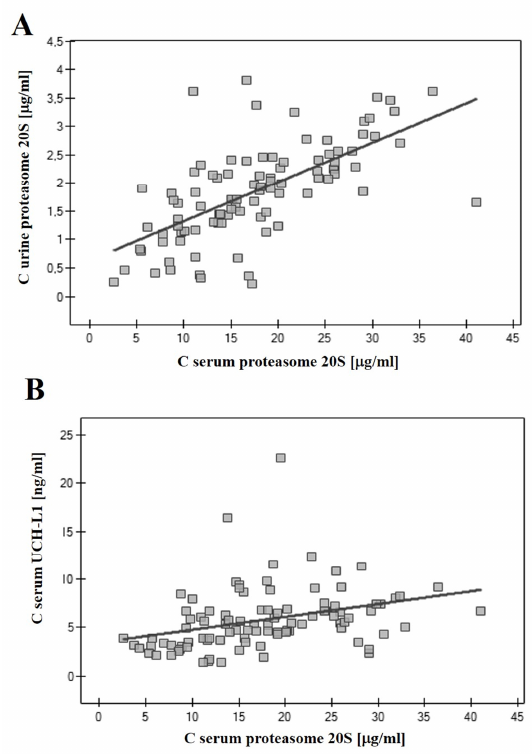
Figure 4. Pearson’s correlation analysis between urine and serum 20S proteasome concentration (r = 0.64) ( A ), and Spearman’s correlation analysis between serum UCH-L1 and serum 20S proteasome concentration (r = 0.47) ( B ). 3.3. UCH-L1 to 20S Proteasome Serum Concentration Ratio The UCH-L1 to 20S proteasome serum concentration ratio was calculated for each case, and an ROC curve was obtained to distinguish patients with bladder cancer and healthy individuals (Figure 5).